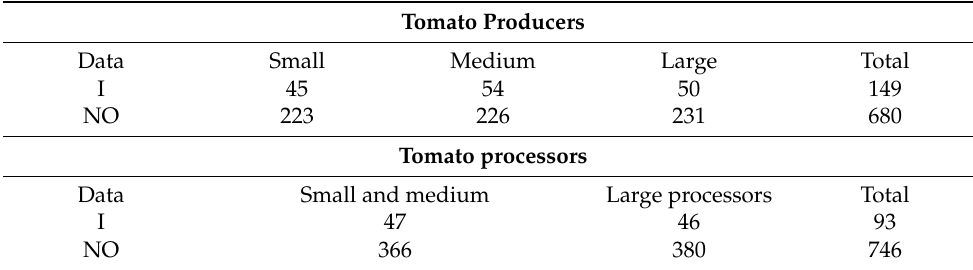
Table 1. Structure of the datasets. Source: FADN and Amadeus. Tomato